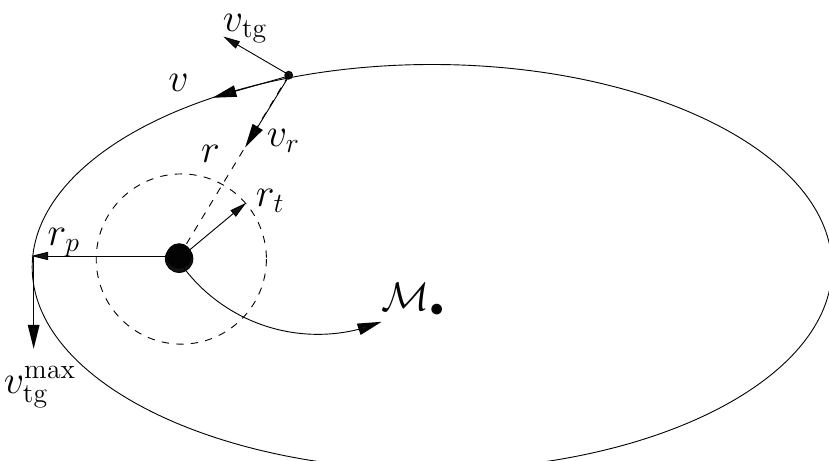
Fig. 20 Definition of the tidal radius “ r t ”, and depiction of the distance of closest approximation of the star in its orbit to the MBH. In this point the radial component of the velocity of the star cancels and the tangential component is maximum. In the figure “ r p ” stands for the periapsis